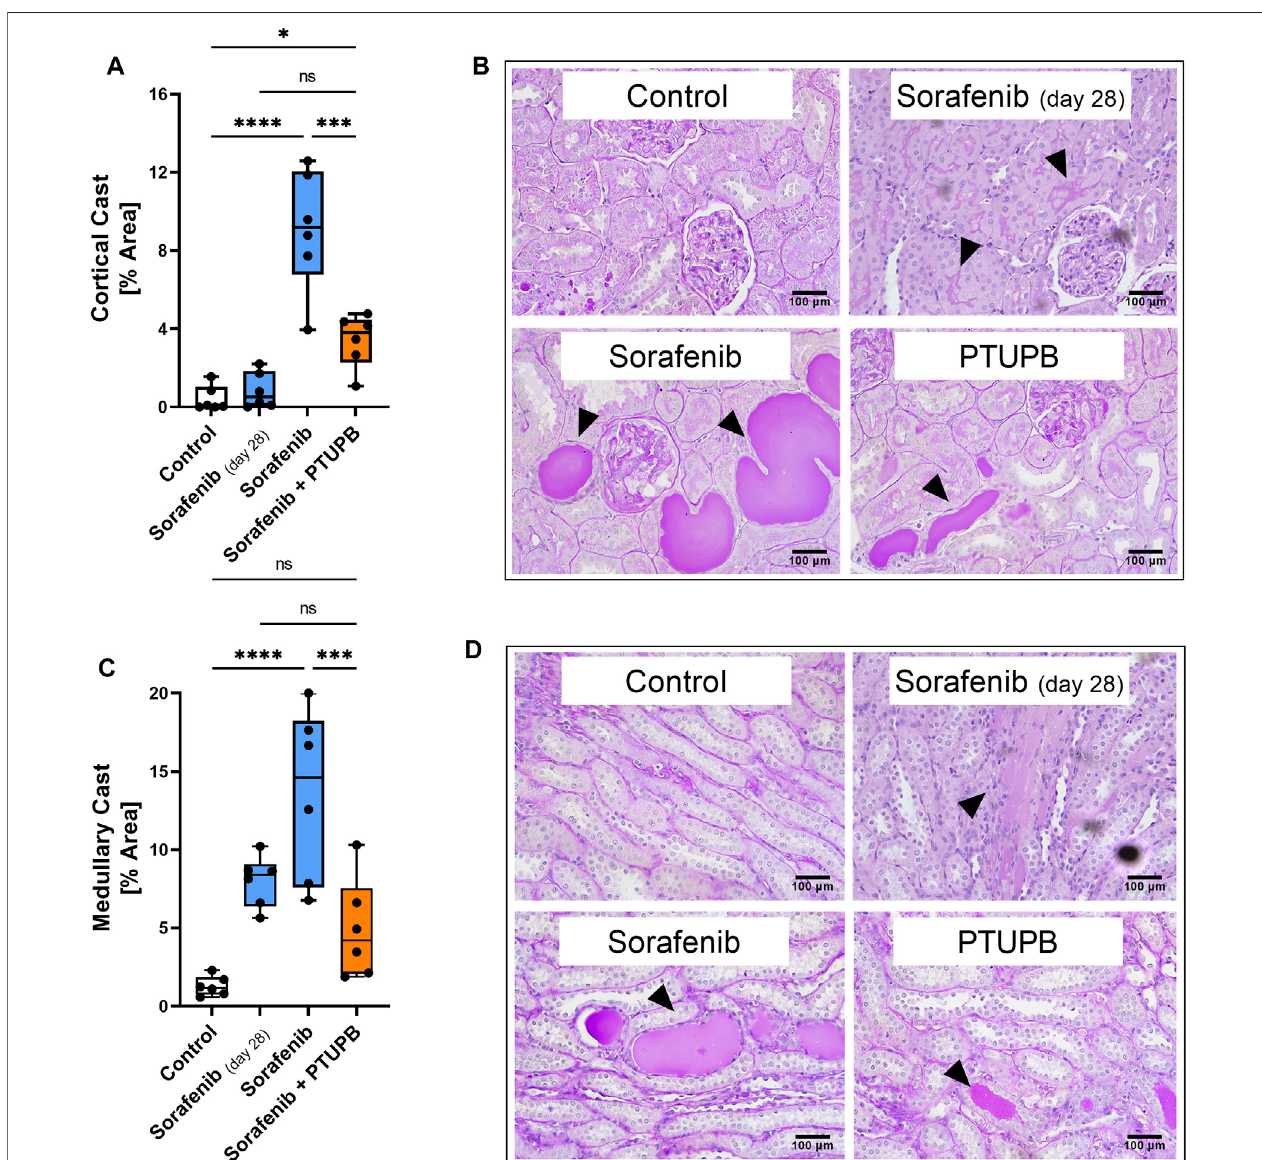
FIGURE 3 | Tubular injury. Sorafenib induced and PTUPB mitigated intratubular cast formation in the cortex (A) . Representative images of cortical casts [periodic acid-Schiff (PAS) staining]. Arrowheads point to cast areas. (B) Sorafenib induced and PTUPB mitigated intratubular cast formation in the medulla (C) . Representative images of cortical casts (PAS staining). Arrowheads point to cast areas. (D) ( n (cid:1) 6 rats/group. Dots represent the average of duplicate measures for each individual rat., ns p > 0.05, * p ≤ 0.05, ** p ≤ 0.01, *** p ≤ 0.001, **** p ≤ 0.0001 determined by ANOVA followed by the Tukey post-hoc test. Data are reported as box and whisker plots with median, minimum to maximum, and 10 to 90